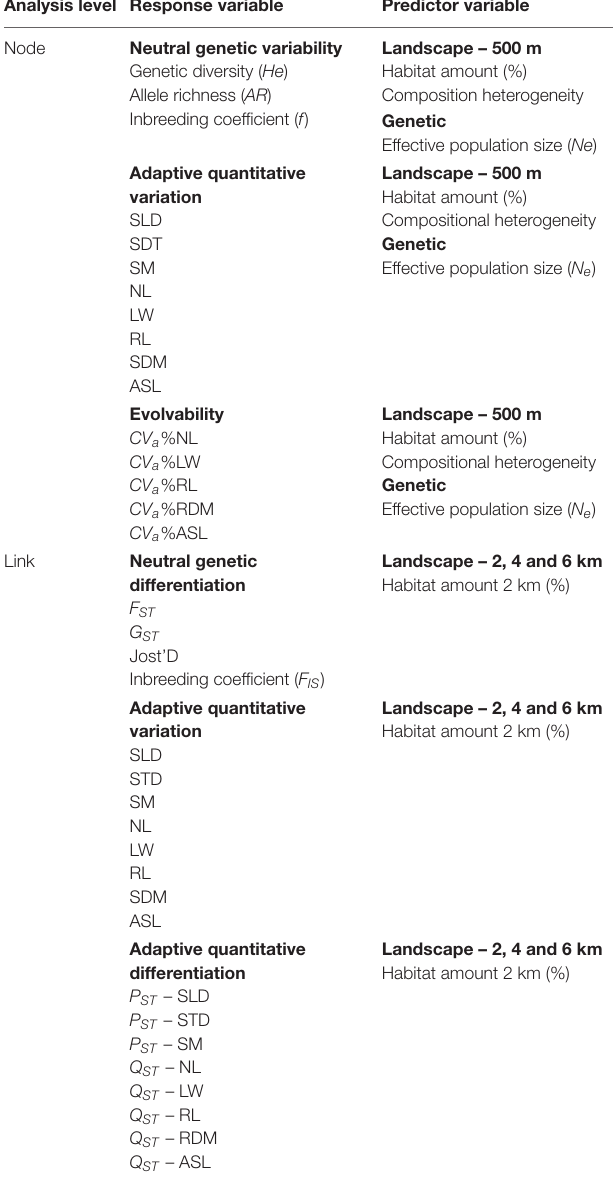
TABLE 1 | Models performed at node and link levels for both neutral and adaptive quantitative traits measured in seeds and seedlings of Tabebuia aurea from 10 sites and 5 landscapes in the Brazilian